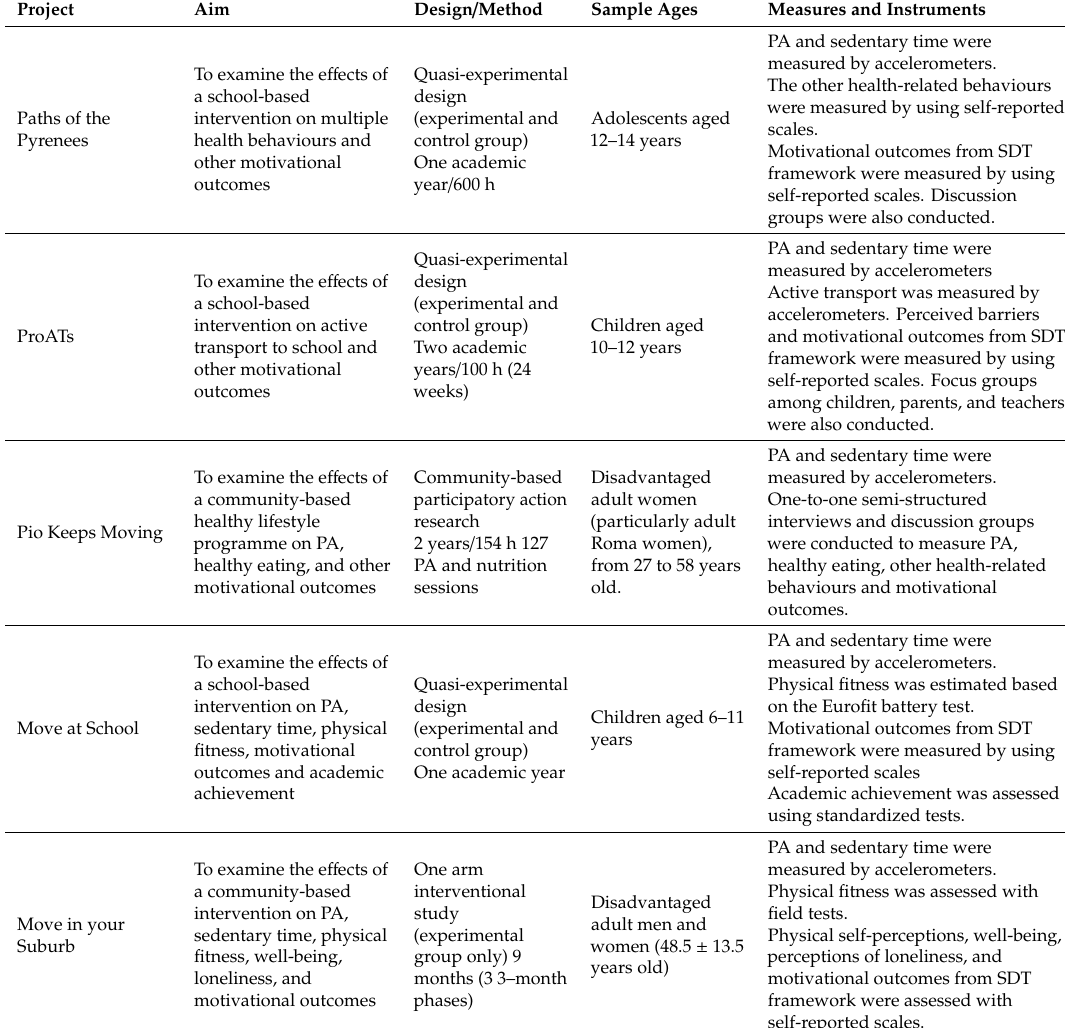
Table 1. Characteristics of multilevel PA interventions conducted by CAPAS-City: aim, design / methods, sample ages, measures and